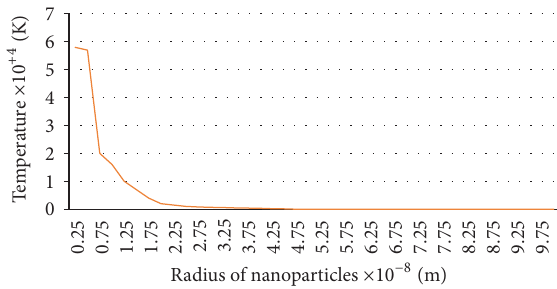
Figure 2: The temperature and radius for silver nanoparticles prepared by laser of pulse duration 6ns and 740 mJ energy.